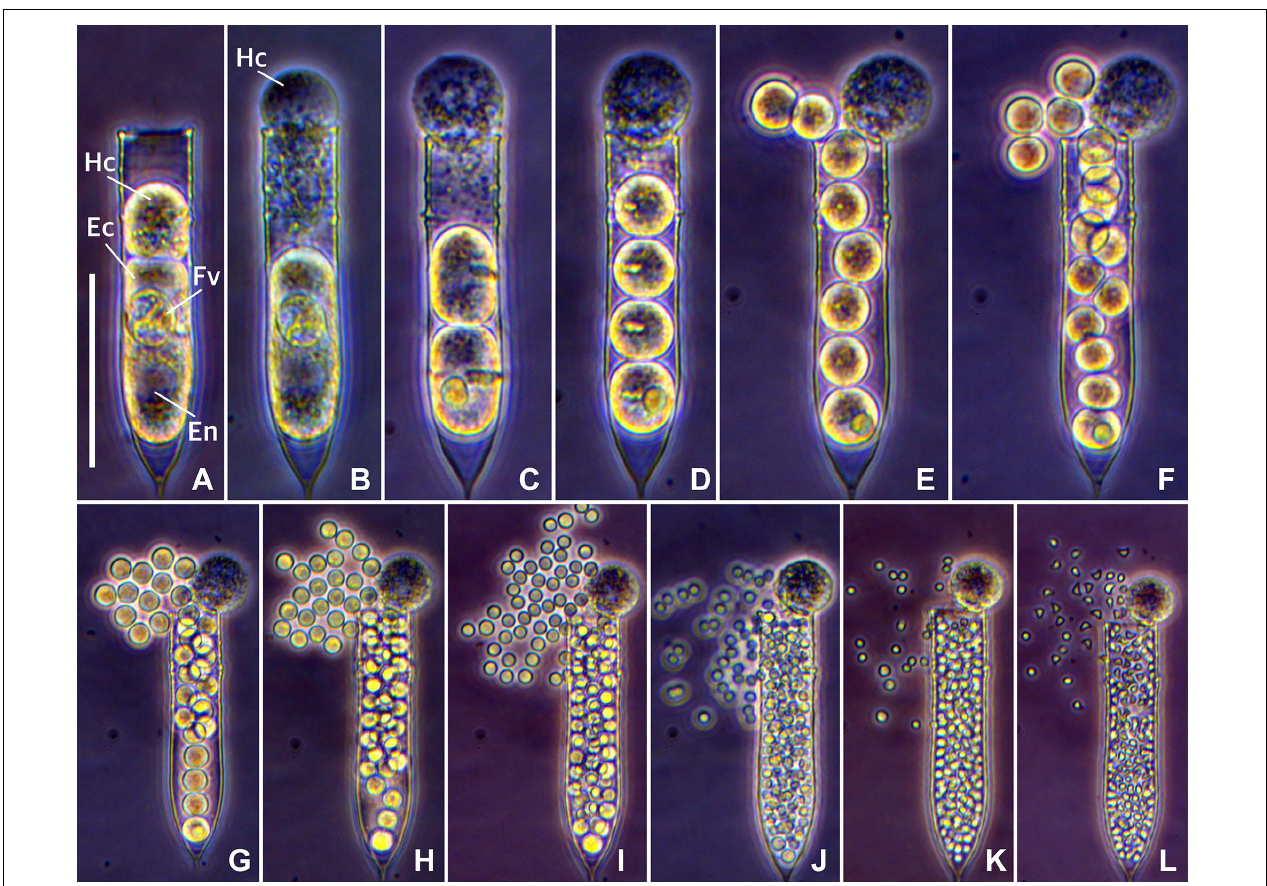
FIGURE 3 | Time-lapse photomicrograph of Euduboscquella triangula sporogenesis resulting in the development of triangular-shaped spores. (A) Mature trophont emerging from the host (required about 10 min). (B) Tomont with food vacuole in lorica (persisted for about 30 min). (C–K) Sporogenic divisions occurring at 15–20 min intervals. (L) Spherical spores transformed into triangular-shaped spores (required about 2 hours). Fv, food vacuole; Hc, host cytoplasm; Ec, Euduboscquella cytoplasm; En, Euduboscquella nucleus. Scale bar = 50 µ